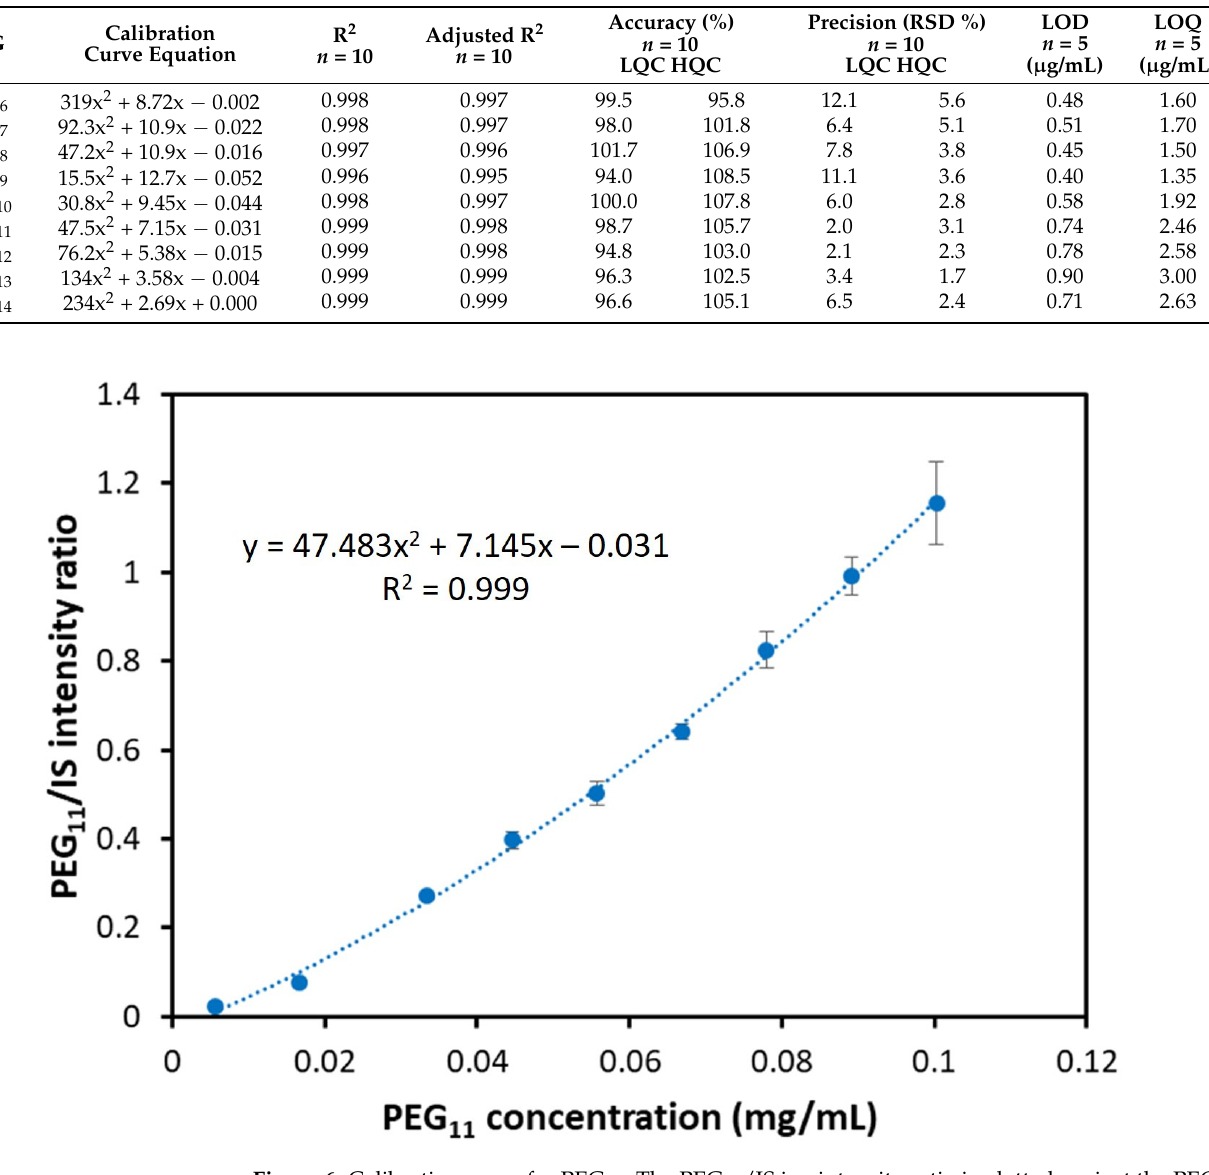
Table 1. The R 2 values of the quadratic regression model, accuracy, precision, limit of detection, and limit of quantification of the PEG oligomers in human urine. The mean values of n replicates are presented.